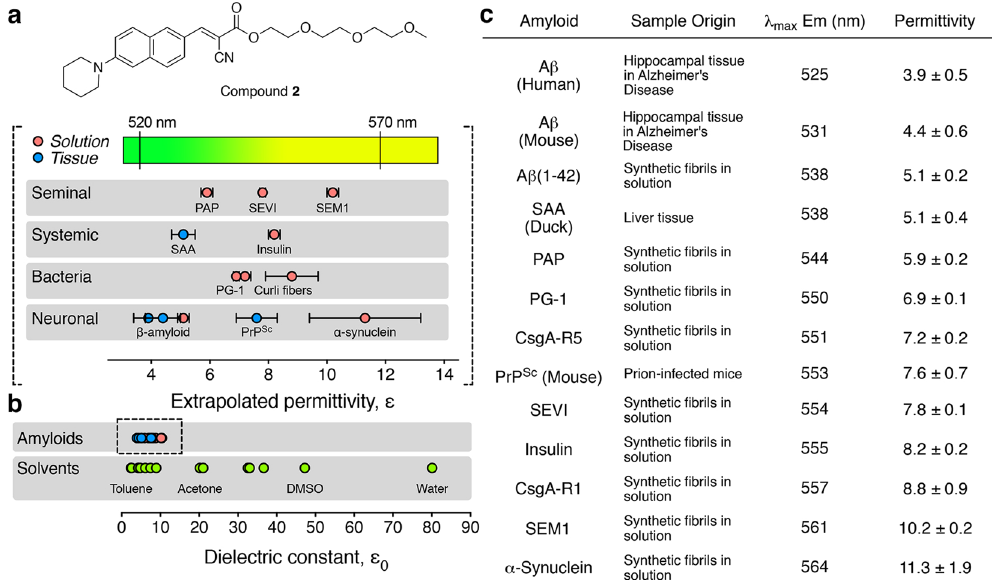
Figure 1. Fluorescence discrimination of amyloids using ANCA compound 2 as a spectroscopic ruler. ( a ) Structure of compound 2 and the maximal fluorescence emission wavelength observed (and associated extrapolated environment polarities) when this compound is bound to different amyloids. ( b ) Comparison of extrapolated permittivities of amyloid binding pockets relative to common solvent permittivities. ( c ) Tabulated emission and extrapolated permittivity values for compound 2 bound to different amyloid aggregates. See supporting information for description of amyloid species